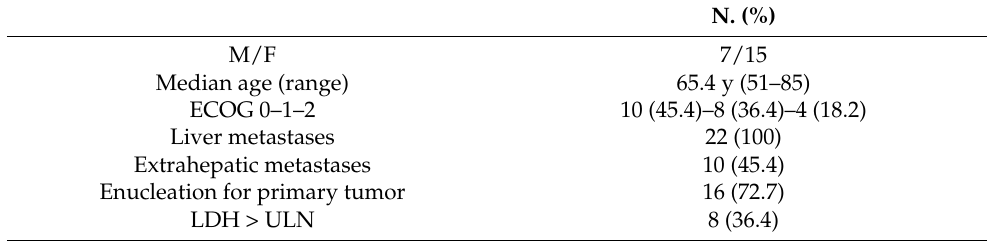
Table 1. Patients’ characteristics.